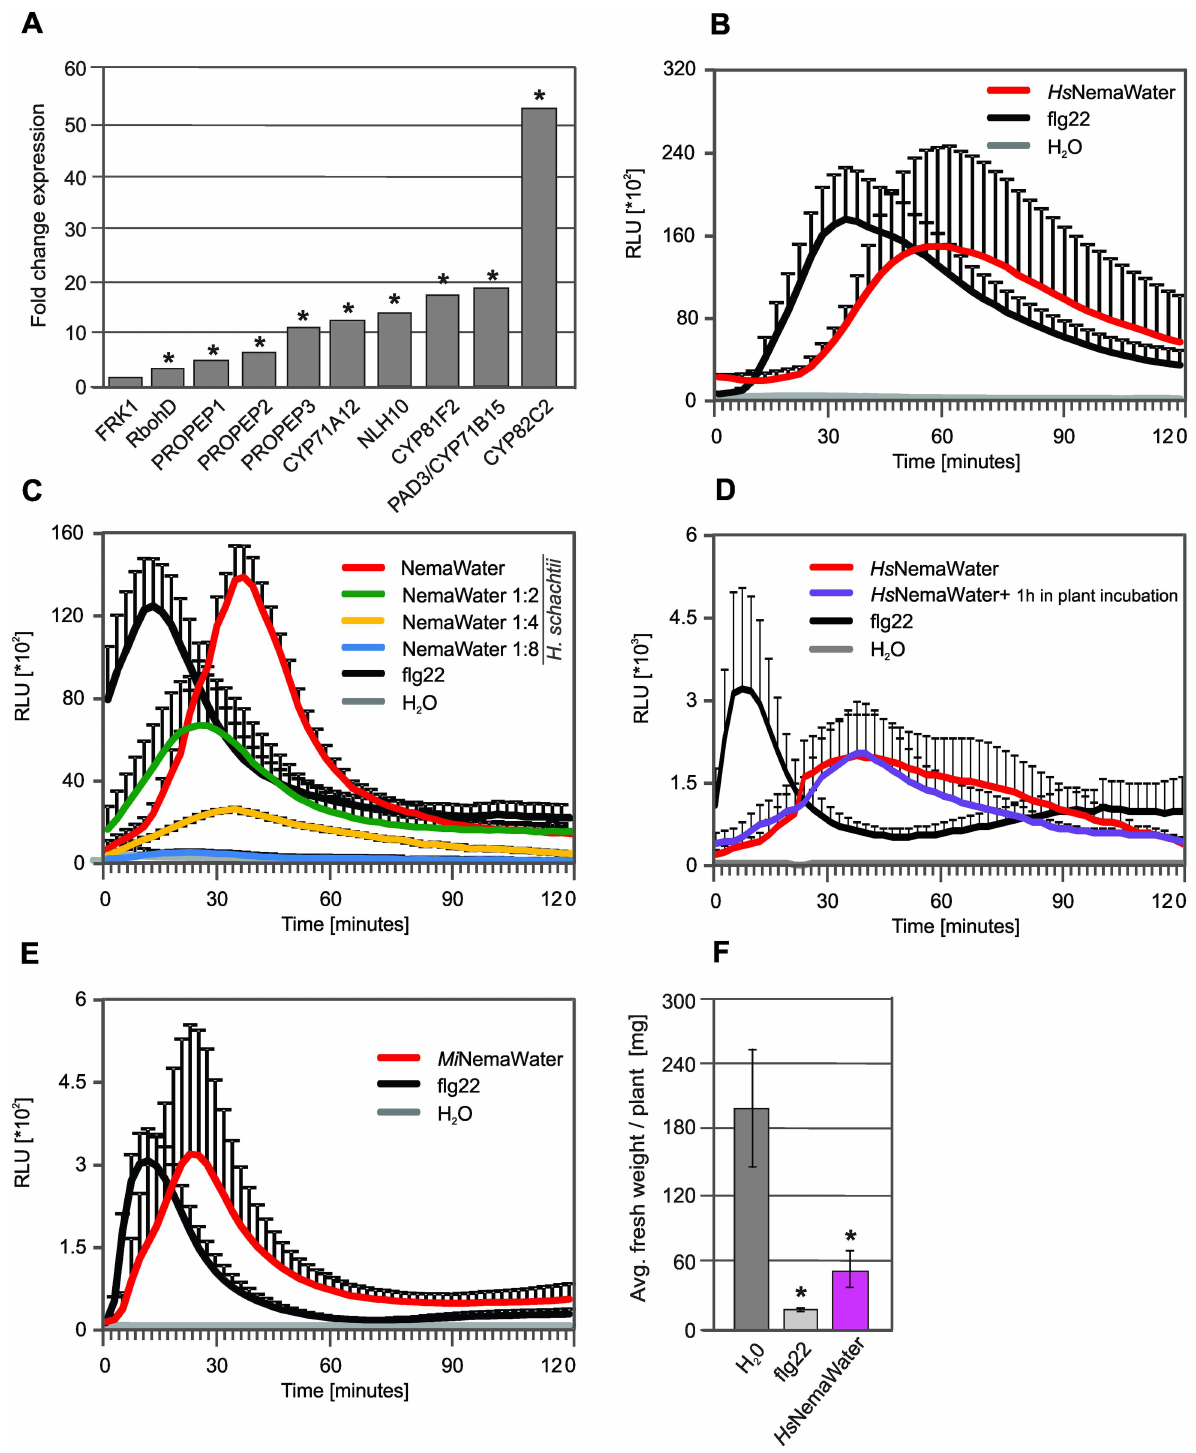
Fig 1. Nematode infection induced defense responses in plants that are characteristics of PTI. (A) Expression of PTI marker genes in microarray analysisupon nematodeinfectionin migratory stage. Root segments from uninfectedroots were used as control. Values indicatefold change comparedwith control. Asterisk indicatessignificantdifference to control (FDR < 0.05; Fold change > 1.5). ( B ) Root segmentsfrom Col-0 plants were treated with water, Hs NemaWater or flg22 and ROS burst was measured using L-012 based assay from 0 to 120 min. ( C ) Root segmentsfrom Col-0 plants were treated with water, different dilutions of Hs NemaWater or flg22 and ROS burst